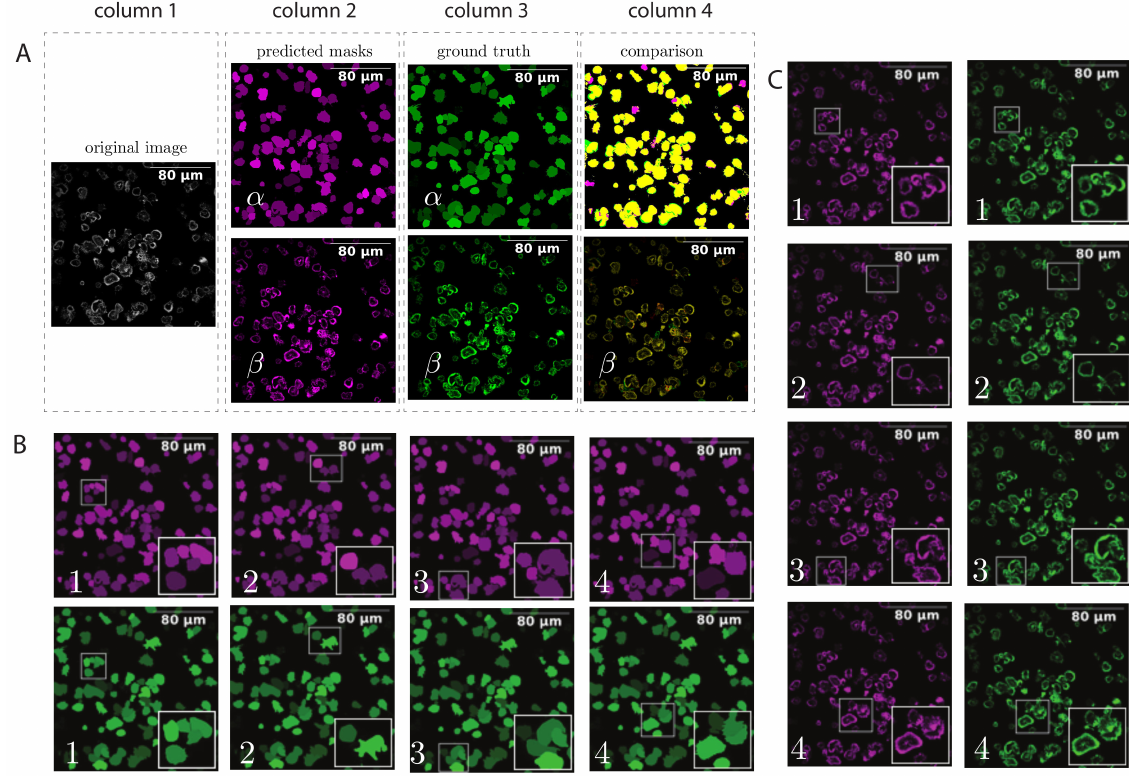
Fig 4. Comparison of generated instance segmentation masks in the evaluation phase with their ground truths. We applied colormaps ’Magenta’, ’Green’, and ’Yellow’ for better representation of the images. Different shades are used to separate the cells from each other. Four different zooming areas are selected for analysis. The images with the same number point to the same zooming area.